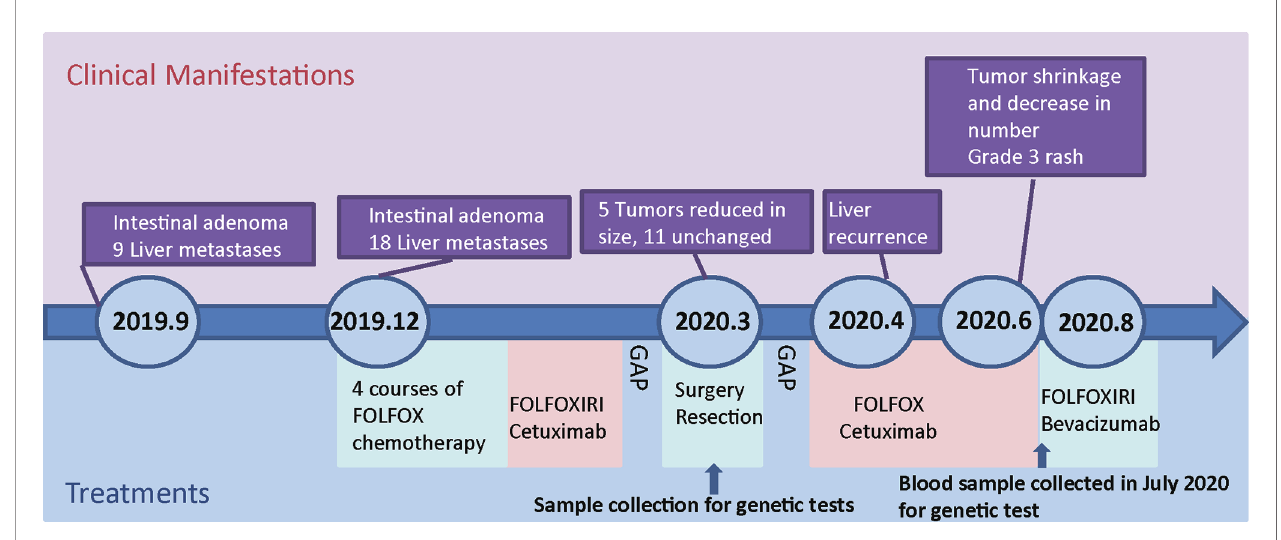
FIGURE 3 | Schematic diagram showing treatment record of the